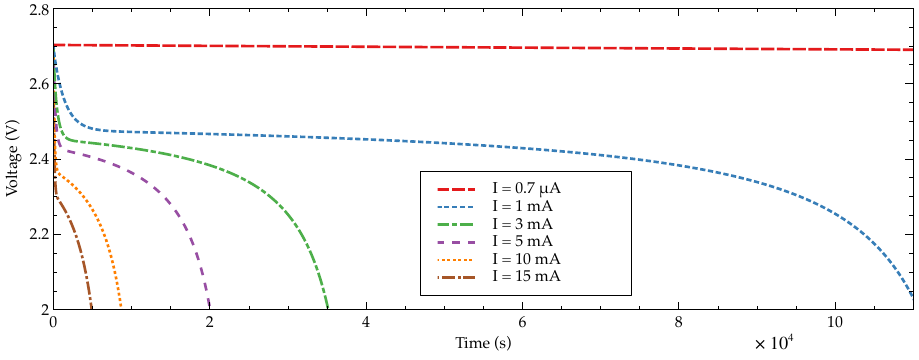
Figure 6. Voltage behavior of a battery when discharged at several constant